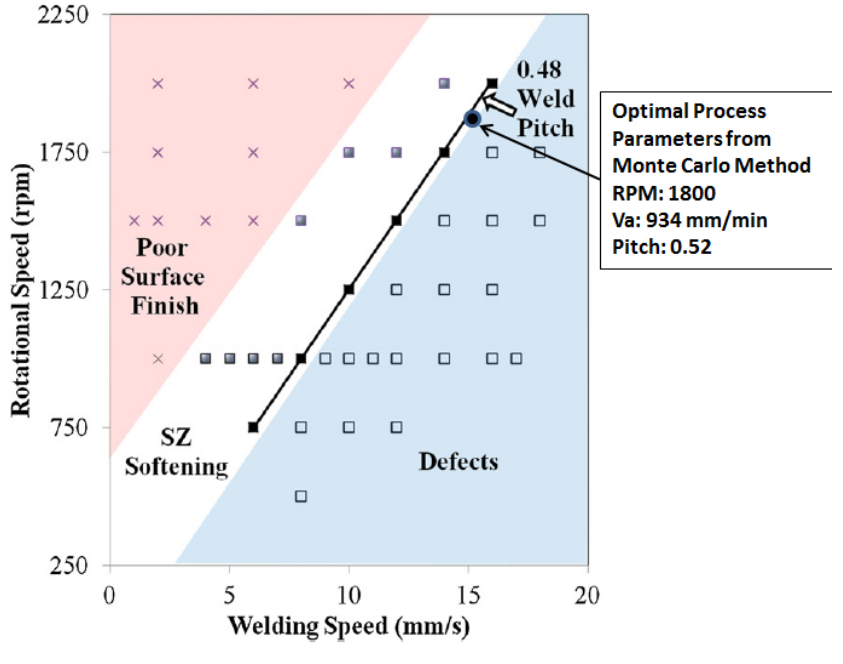
Figure 12. Processing map for FSW of 3.18mm 6061-T6 plate [26] (Adapted from